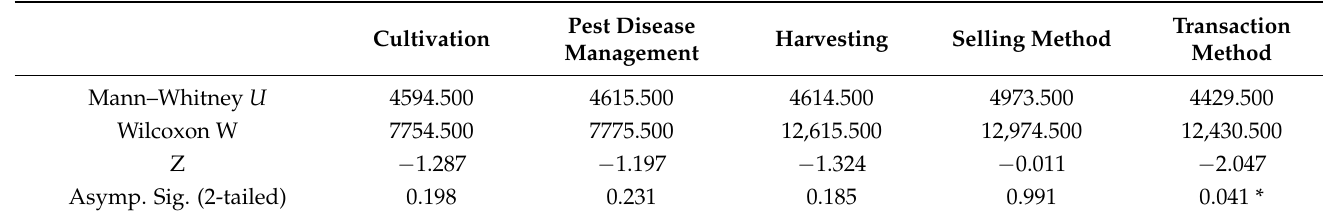
Table 7. Mann–Whitney analysis for the COVID-19 effects on the process aspect of coffee farming systems.